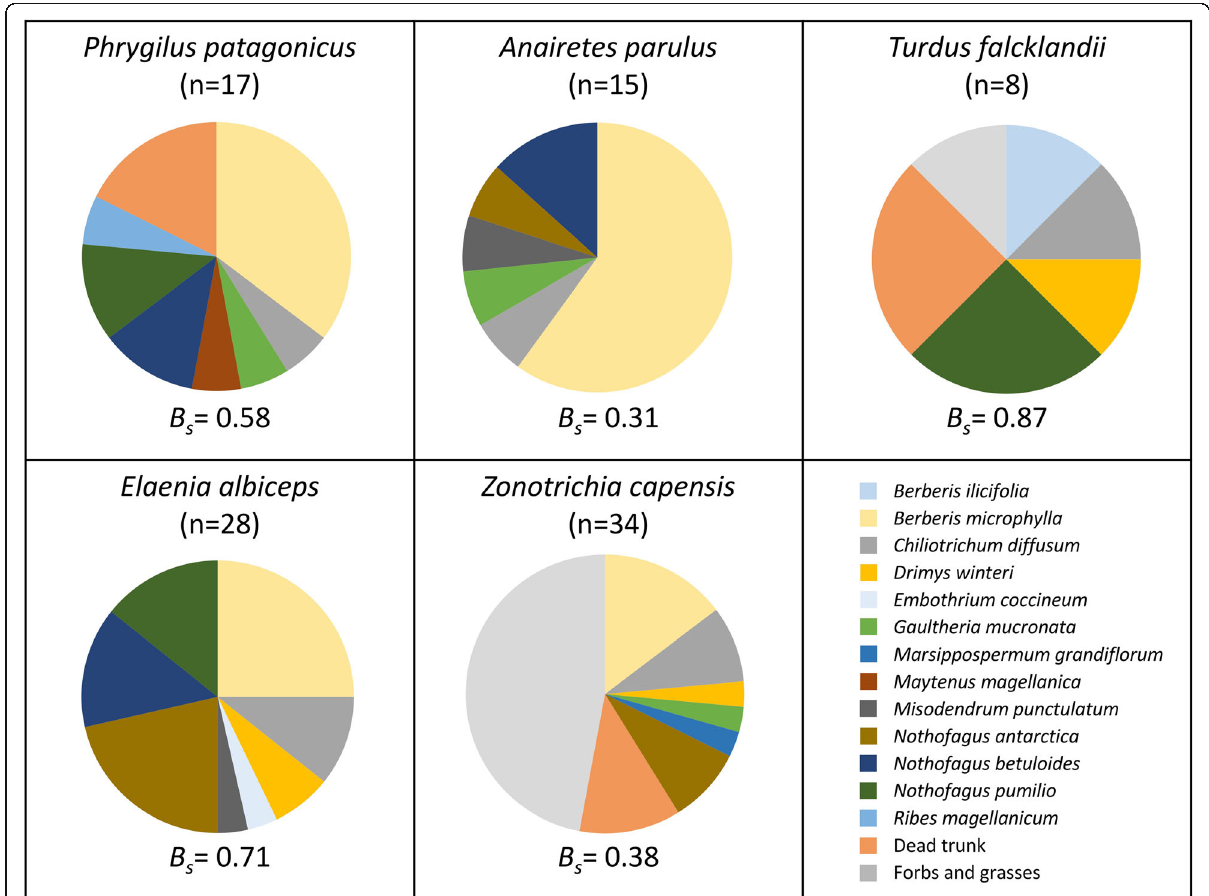
Fig. 3 Substrates used for nesting by five open-cup forest-nesting passerines that breed on Navarino Island (55°S), Cape Horn Biosphere Reserve, Chile. Sample sizes are in parentheses. B s represents the standardized Levins ’ niche breadth